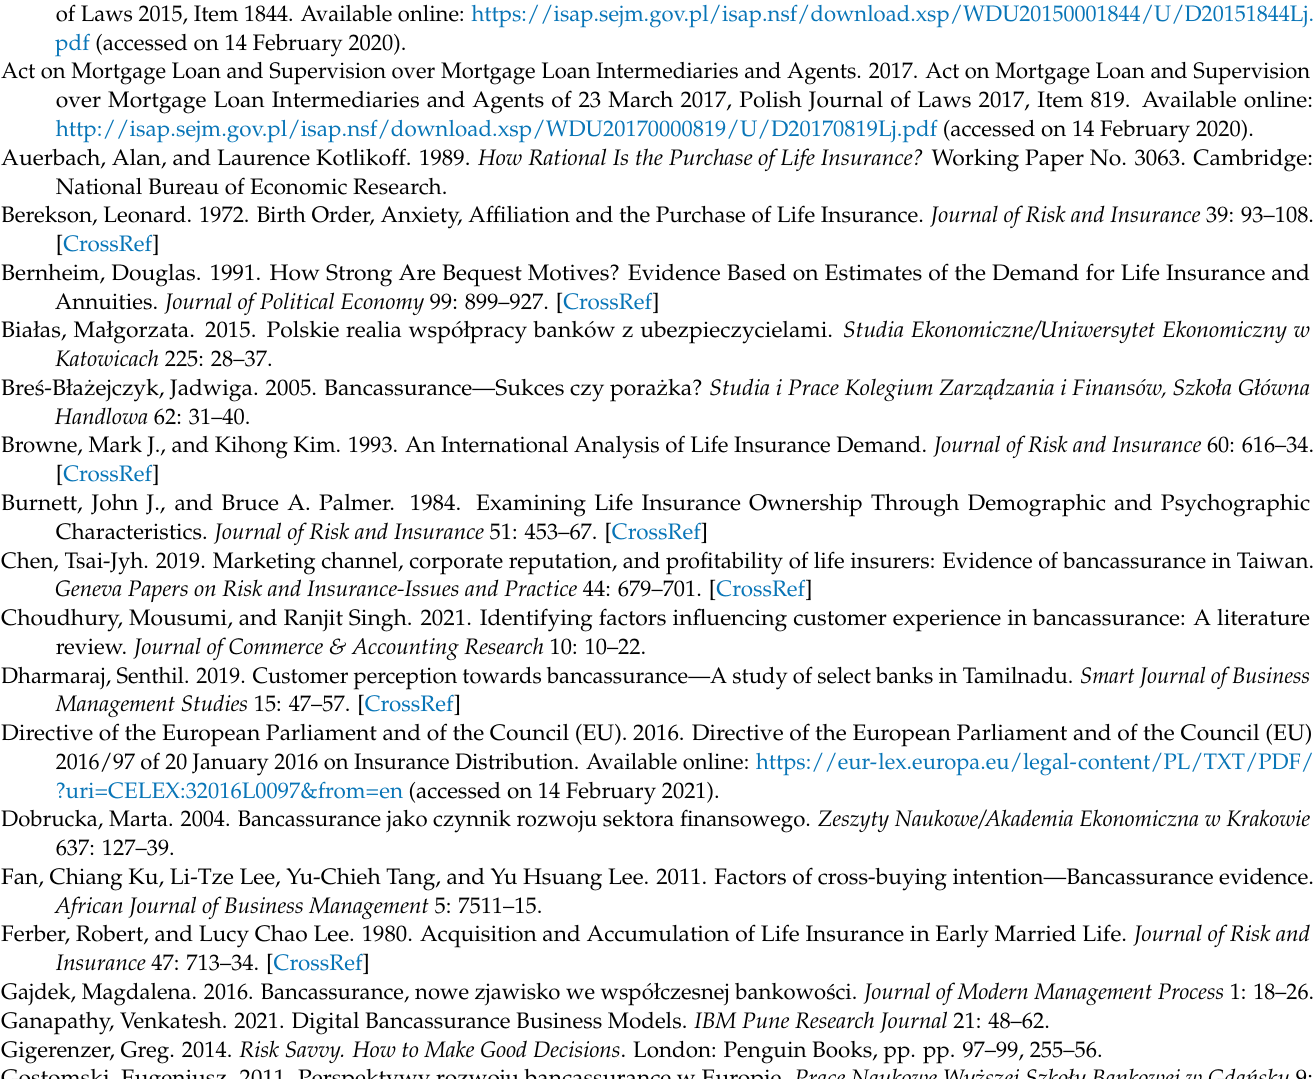
Figure A3. Bancassurance share in Section I gross premiums written, source: own study based on KNF’s data: (Polish Financial Supervision Authority 2001–2019).